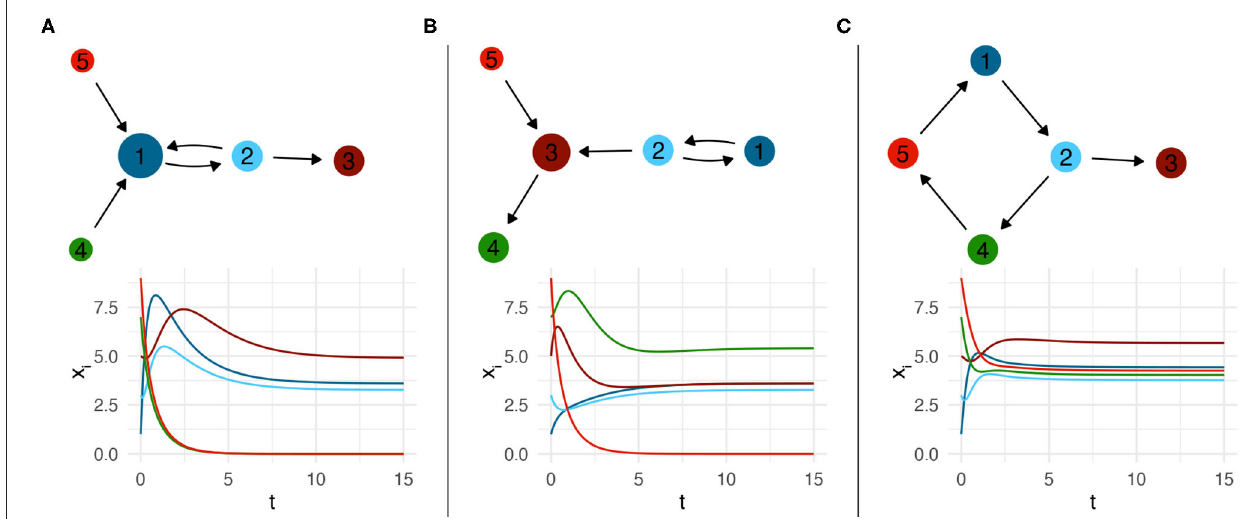
FIGURE 1 | Dynamics of the knowledge stock, Equation (1), in a small network of 5 firms. The size of a node is proportional to its in-degree. The color of the each knowledge stock’s line matches that of the corresponding node in the respective network. (A–C) show the dynamics for three different network